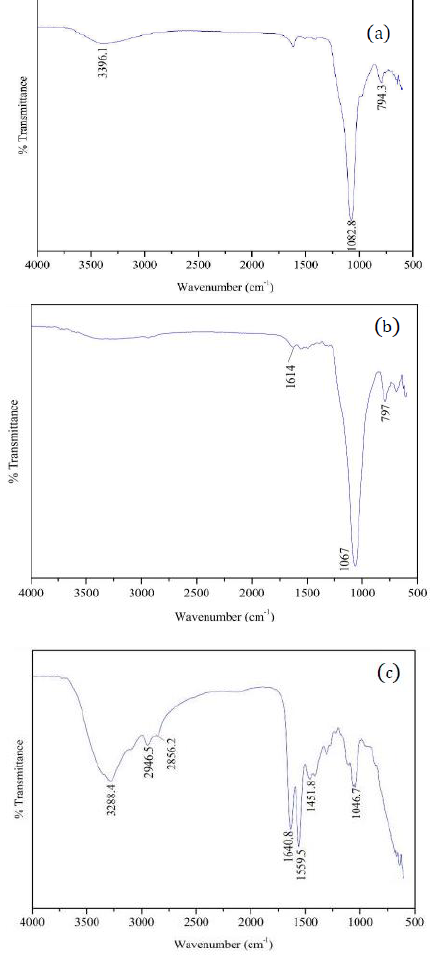
Figure 1. The ATR-IR spectra of: hydroxylated silica ( a ); silanized silica ( b ); and core-shell particle (CSP) ( c ) particles.